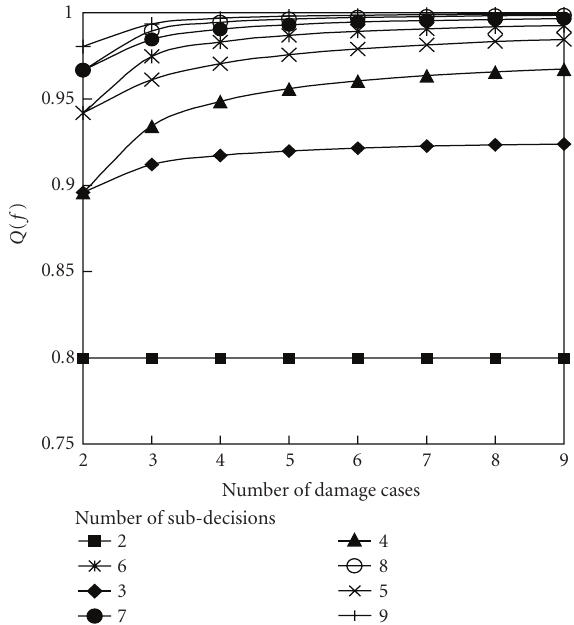
Figure 3: PCS of system versus number of damage cases in case of Q 0 = 0 . 8.